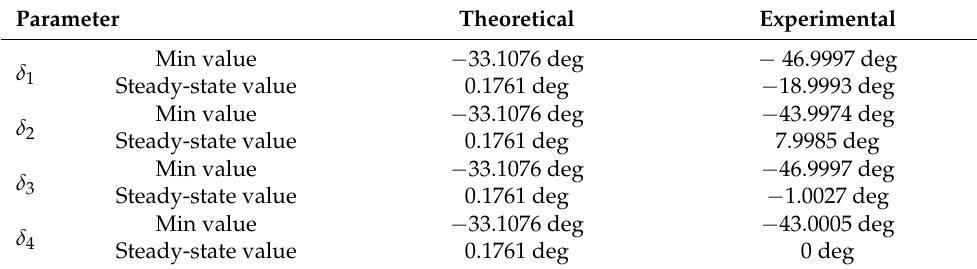
Table 8. Gimbal angle values for 90 deg maneuver.